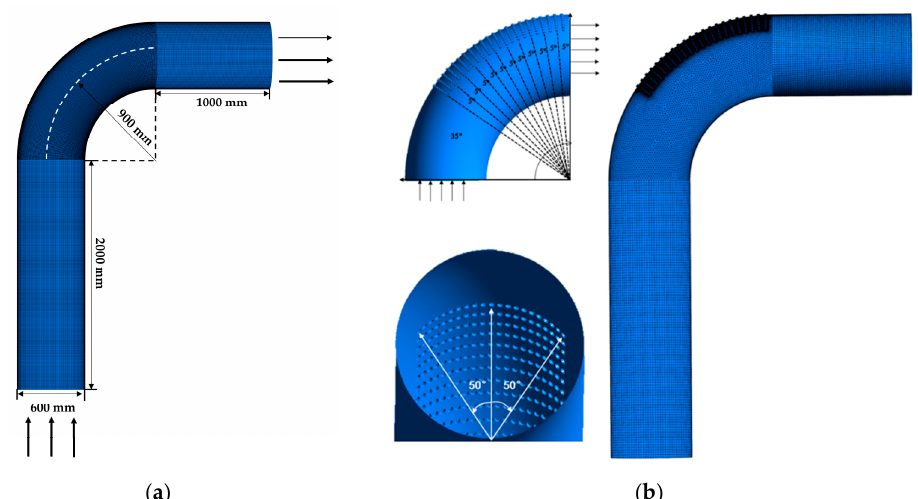
Figure 5. Geometric models: ( a ) elbow; ( b ) elbow with holes.